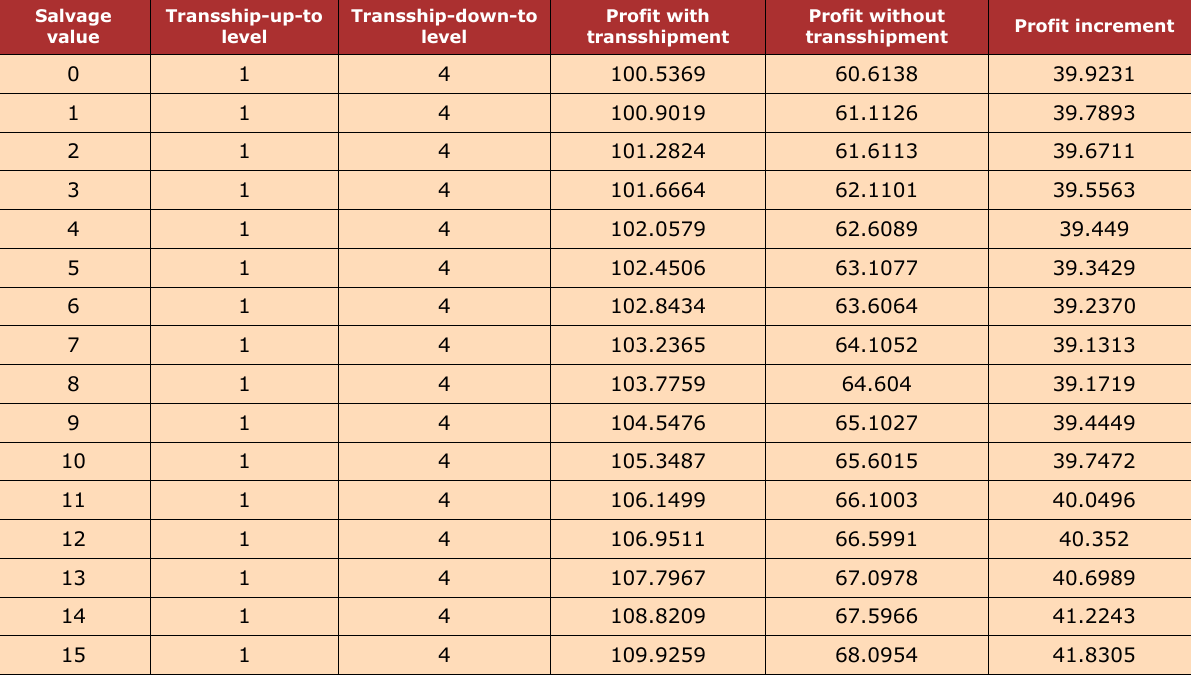
Table 2. Relation between profit, transshipment and salvage